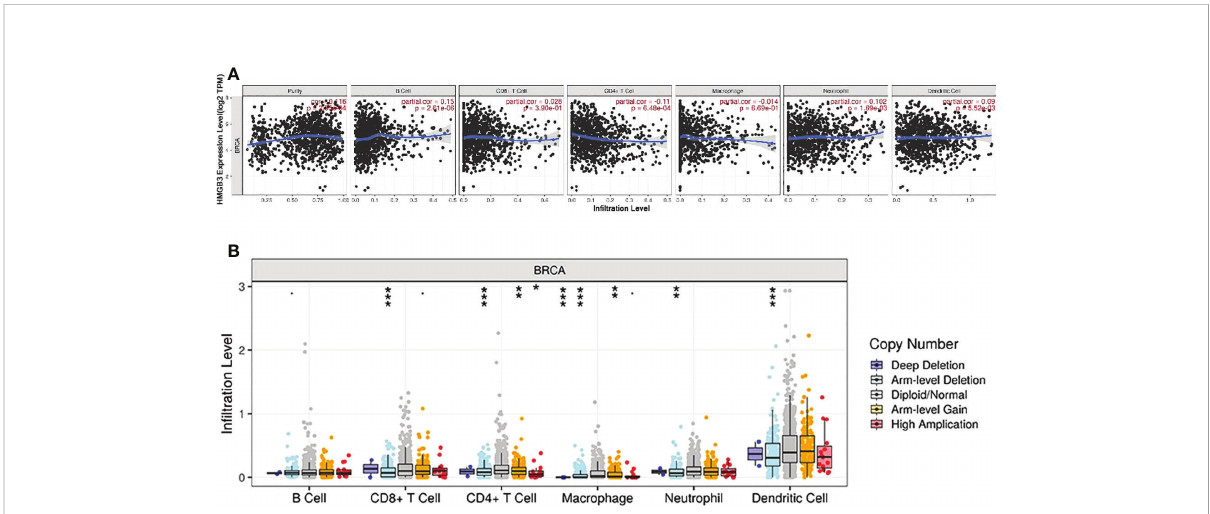
FIGURE 5 Correlation between breast cancer immune cell in fi ltration levels and HMGB3 expression. (A) Relationship between high levels of immunological in fi ltrates and HMGB3 expression. (B) Relationship between HMGB3 somatic copy number variations and the volume of immunological in fi ltrates. *p<0.05, **p<0.01,